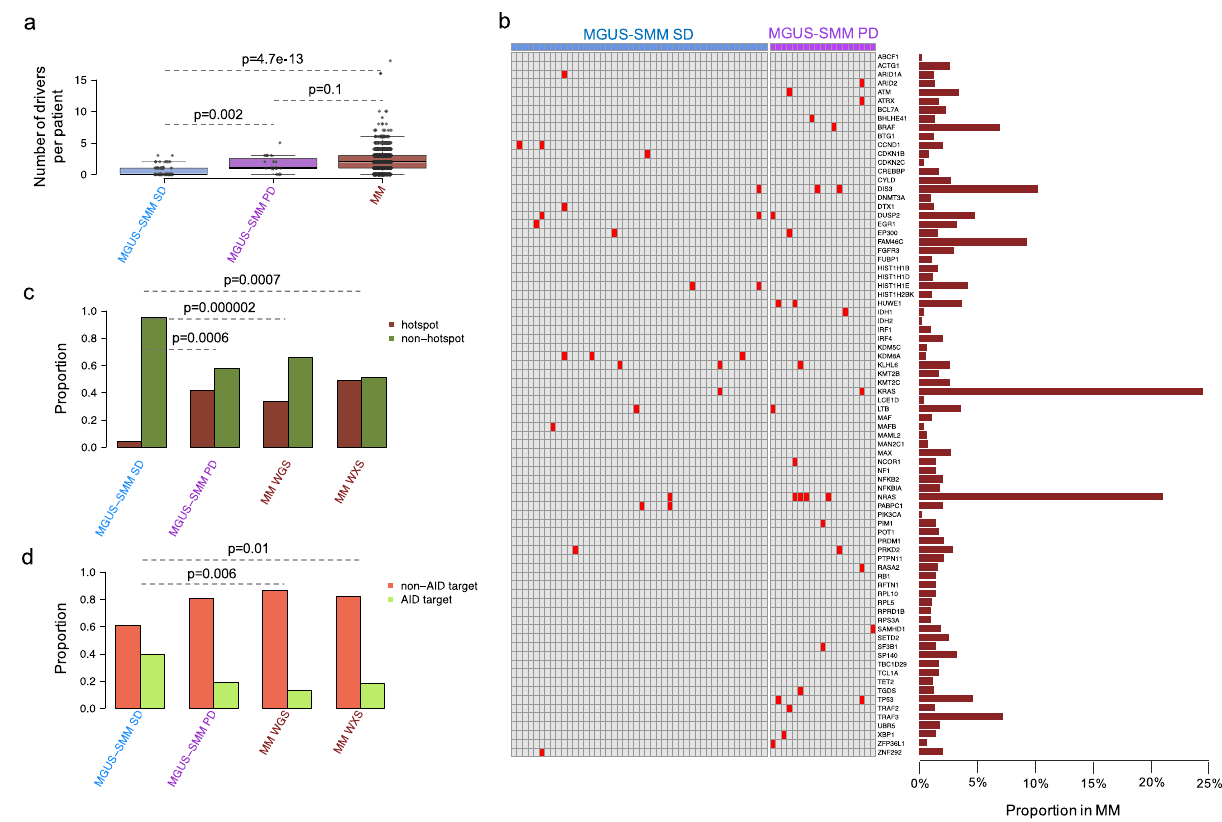
Fig. 3 Mutations in myeloma driver genes. a , b Prevalence and distribution of nonsynonymous mutations in driver genes ( N = 80) across stable (blue; N = 15) and progressive (purple; N = 17) myeloma precursor condition and multiple myeloma (brown). In ( b ) red: mutated; Gray: wild type. p values were calculated using Wilcoxon rank-sum test. Boxplots show the median and interquartile range. c Proportion of cases with at least one signi fi cant known hotspot mutation (brown) within myeloma driver genes in stable and progressive myeloma precursor condition and multiple myeloma (MM). d Proportion of mutations in driver genes involving known AID targets (light green) in stable and progressive myeloma precursor condition and MM. MGUS: monoclonal gammopathy of undetermined signi fi cance, SMM: smoldering multiple myeloma, SD: stable, PD: progressive, WGS: whole-genome sequencing, WXS: whole exome sequencing. Asterisks in ( c , d ) indicate a p < 0.01 under Fisher ’ s exact